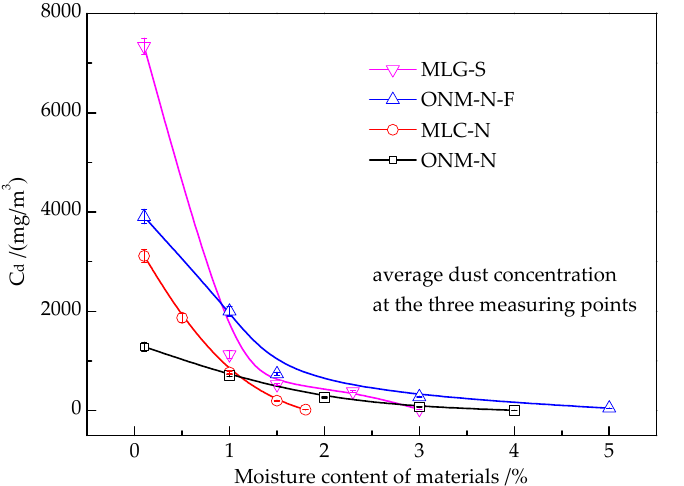
Figure 4. Effects of the moisture content of materials on the average dust concentration of chute at the three measuring points.